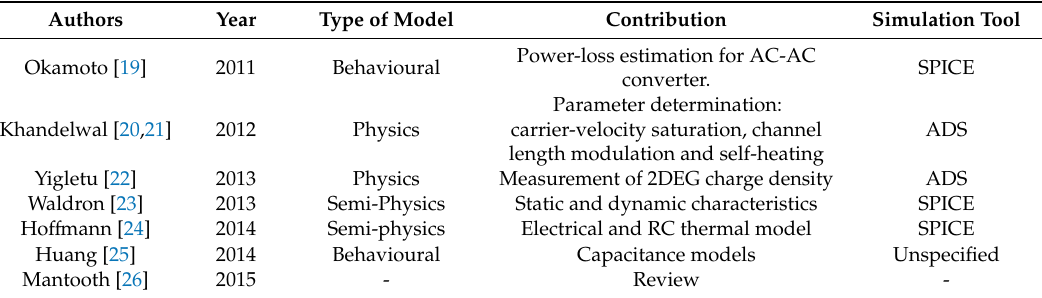
Table 1. Review of existing GaN models